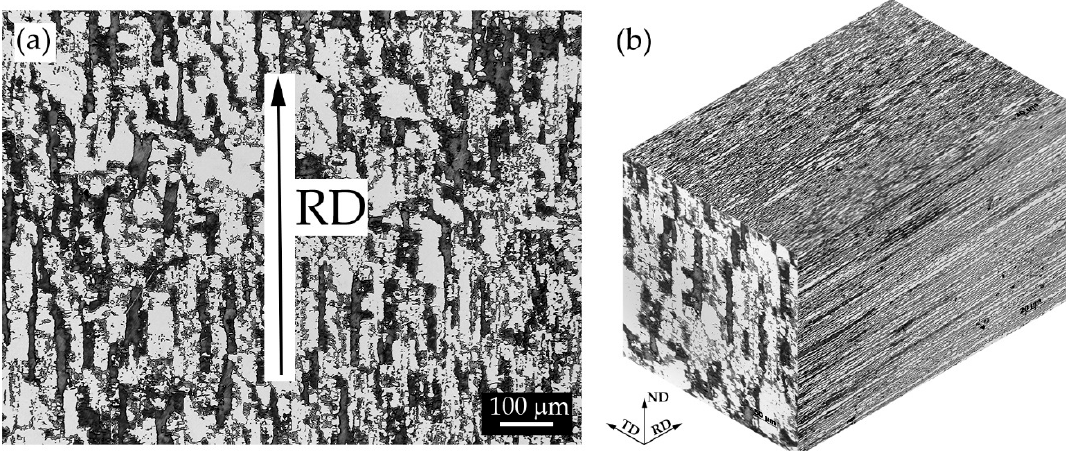
Figure 4. Microstructure of the as received materials: ( a ) along the rolling direction (RD) and ( b ) along the main three directions ( b ). Etching solution NaOH at 3 V and 5 s.